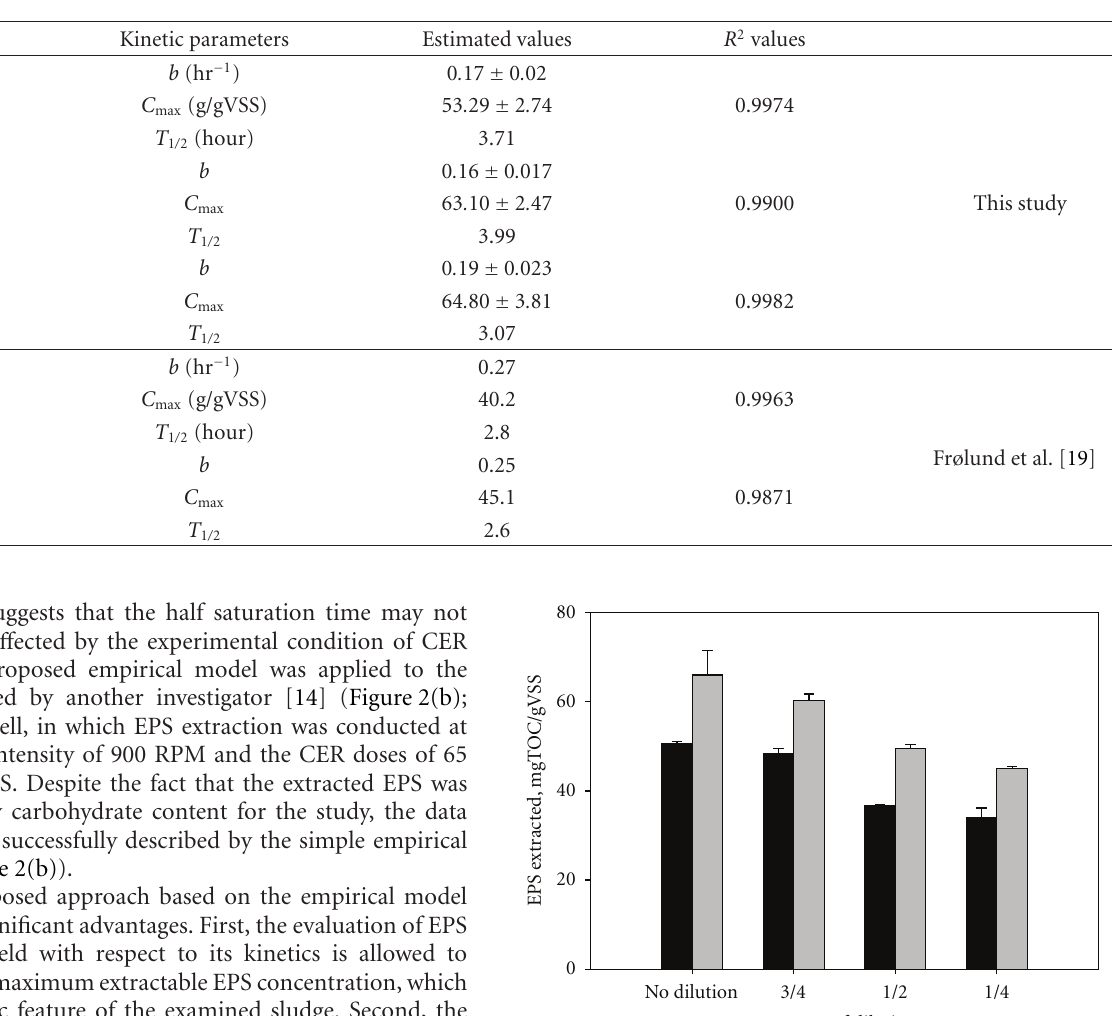
Table 2: Estimated kinetic parameters ( b , C max , T 1 / 2 ) based on the best fit of the empirical model for di ff erent resin doses. The stirring in- tensity is 600RPM.